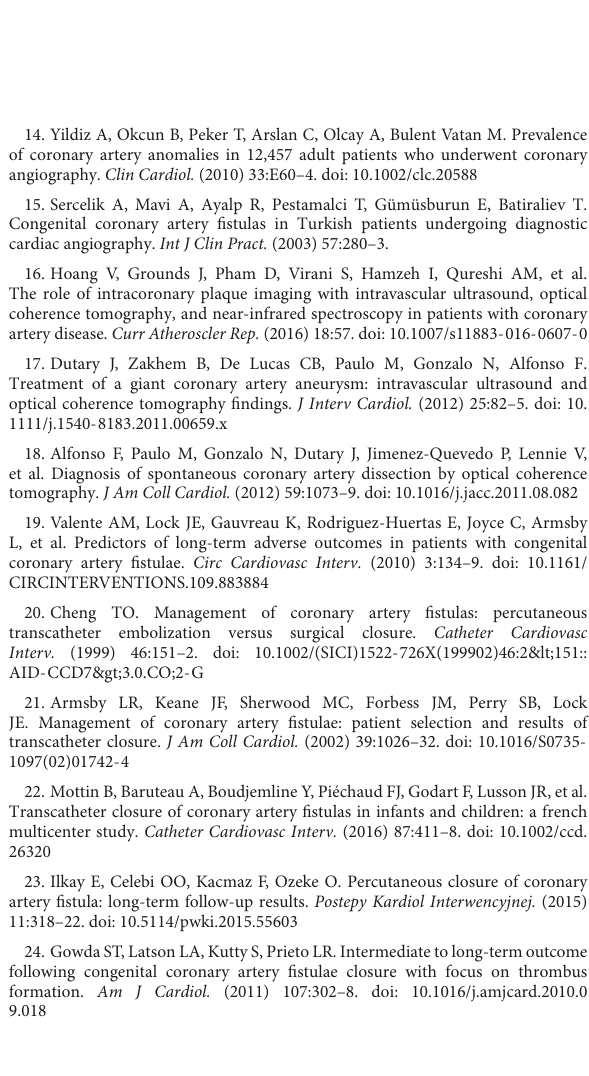
SUPPLEMENTARYFIGURE1 The parasternal long-axis view in TTE shows (A) dilated coronary sinus (white arrow), (B) a well-seated bioprosthetic mitral valve in AC4 view, (C) mid esophageal view in two-dimensional transesophageal echocardiography, showing a tortuous, giant vascular tuft; coronary artery fistula (white arrow), and (D) blue and red colors in color Doppler study indicates “to and fro” movement of the vascular tuft regarding the